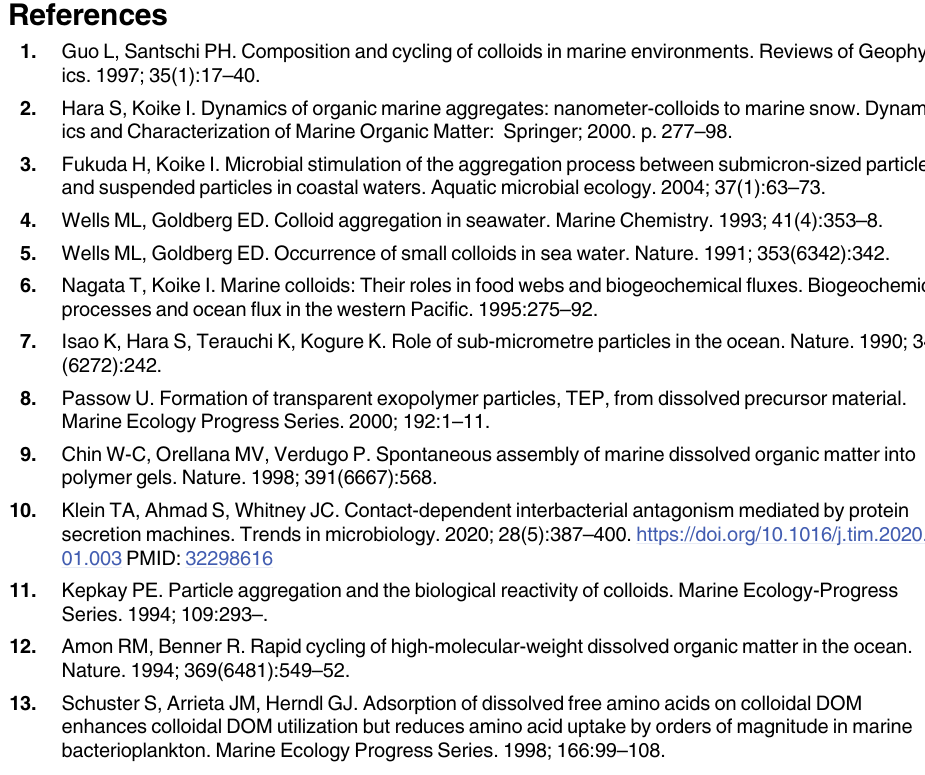
S1 Table. Phylogenetic classification of marine bacterial